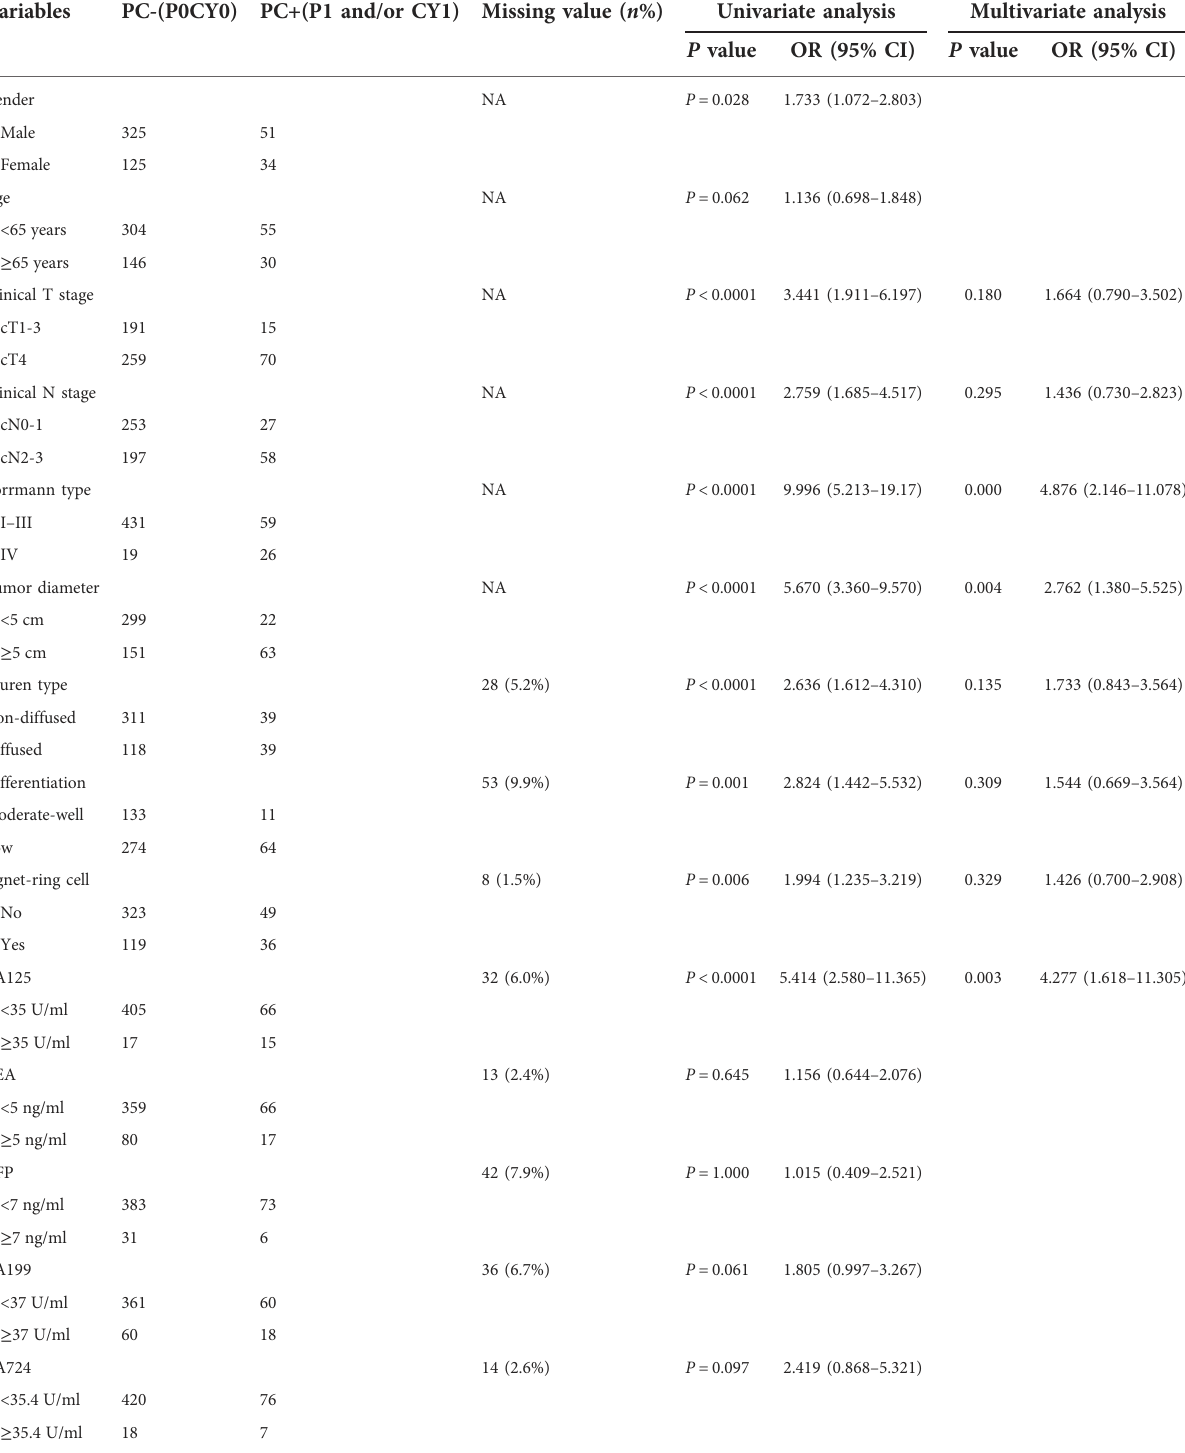
TABLE 1 Clinicopathologic features of patients and results of univariate analysis and multivariate